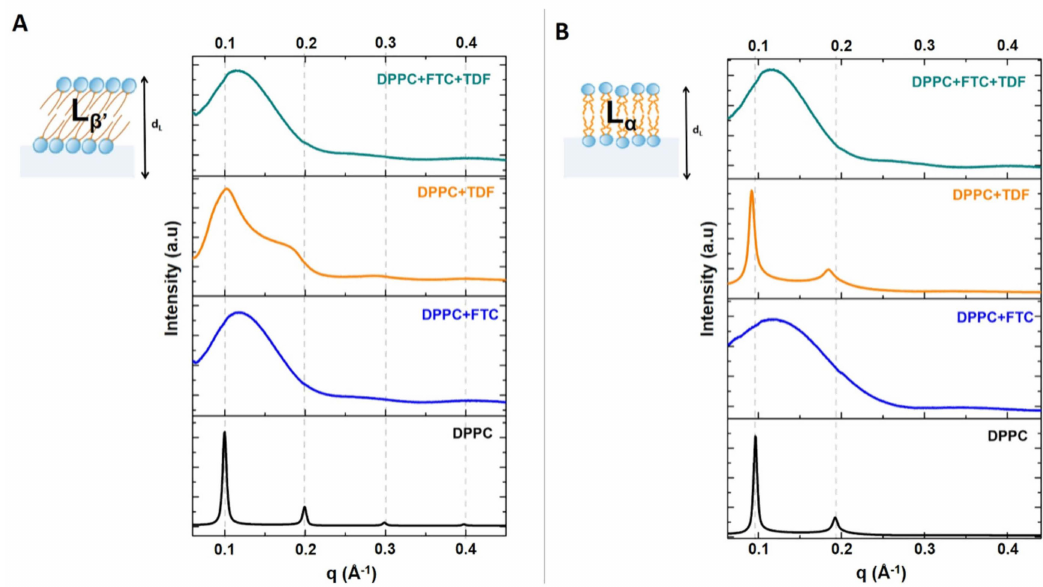
Figure 2. Small angle X-ray di ff raction silver behenat (SAXS) patterns of DPPC (black) or DPPC containing TDF (yellow), FTC (blue), or TDF and FTC (3:2 w / w ) (green) measured in the L β (cid:48) ( A ) and L α ( B ) phases of DPPC. Table 3. Long spacings (d L ) and correlation length ( ξ ) determined from SAXS patterns and short spacings (d S ) determined from p -bromo benzoic acid (WAXS) patterns of DPPC without or with FTC, TDF, and FTC + TDF (3:2 w / w ) in the L β (cid:48) and L α phases. Short-Spacing Values Long-Spacing Values (SAXS) 1 Lipid Bilayers in the Absence or Presence of Drugs